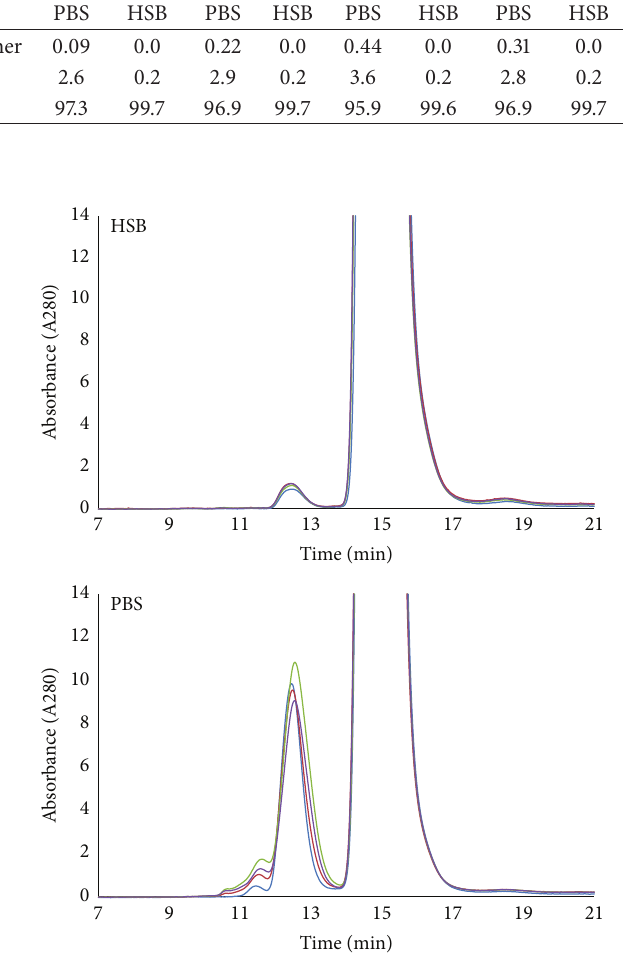
Figure1:HPSECtracesofruthenylatedantibodyconjugatestoredat 1mg/mL in PBS or in HSB. Each preparation was subjected to mul- tiple freeze-thaw cycles by cycling between − 80 ∘ C (approximately 16 hours) and 5 ∘ C (approximately 8 hours) prior to analysis by HPSEC: the light blue color: 0 F/T cycles; the red color: 1 F/T cycle; the green color: 3 F/T cycles; and the purple color: 5 F/T cycles. The retention times, structural designations, and peak areas are shown in Table